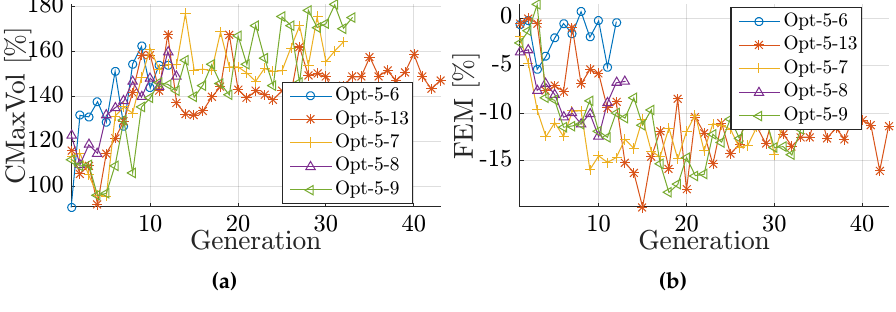
Figure 20. Development of the constraints, given as the generation median relative to baseline design. ( a ) Cavitation volume constraint of Opt-4 (Group 2); ( b ) FEM constraint of Opt-4 (Group 2).